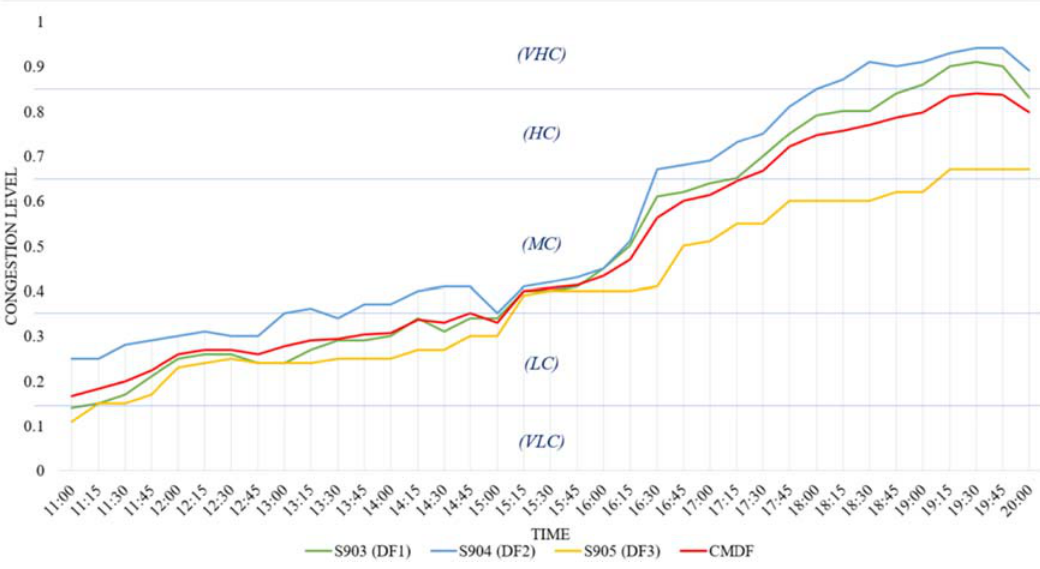
Figure 8: The local and coordinative decisions of each